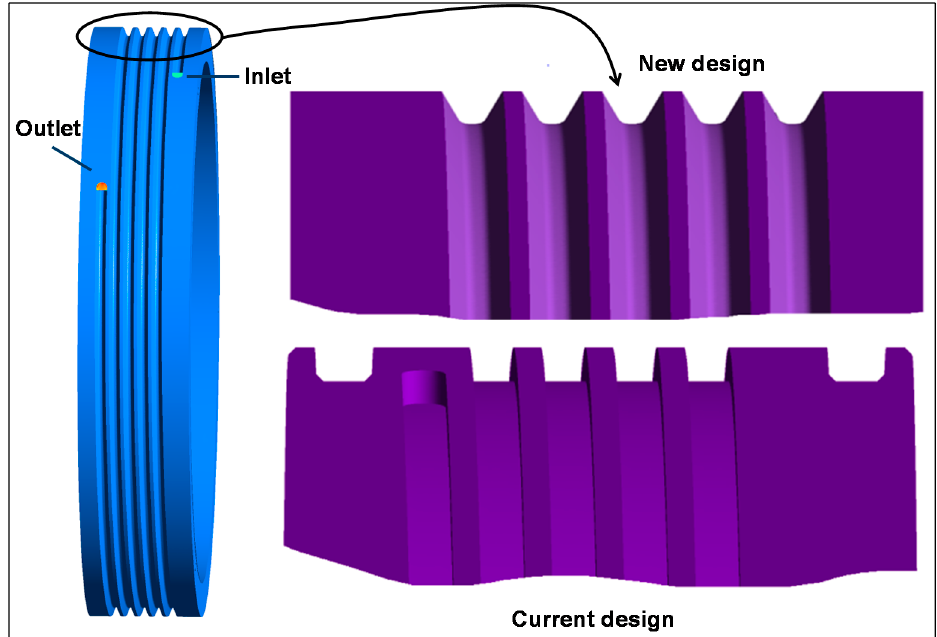
Figure 22. New design with tapered (V-type) fins.